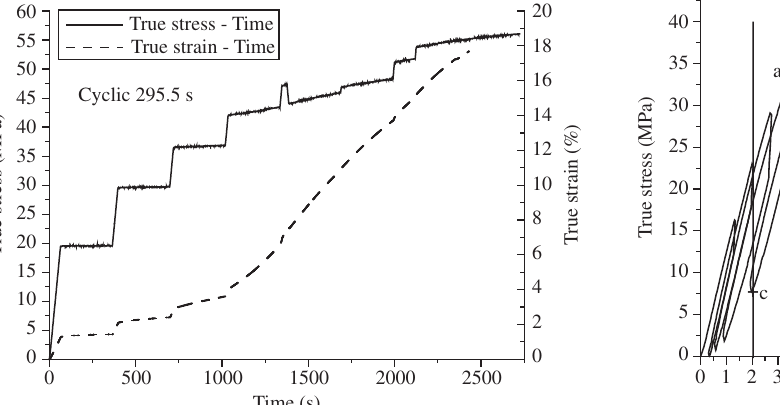
Figure 10. Stress-time and strain-time curves for creep obtained with eq. = ln(1 + ε ) and σ = σ (1 + ε ). ε v v